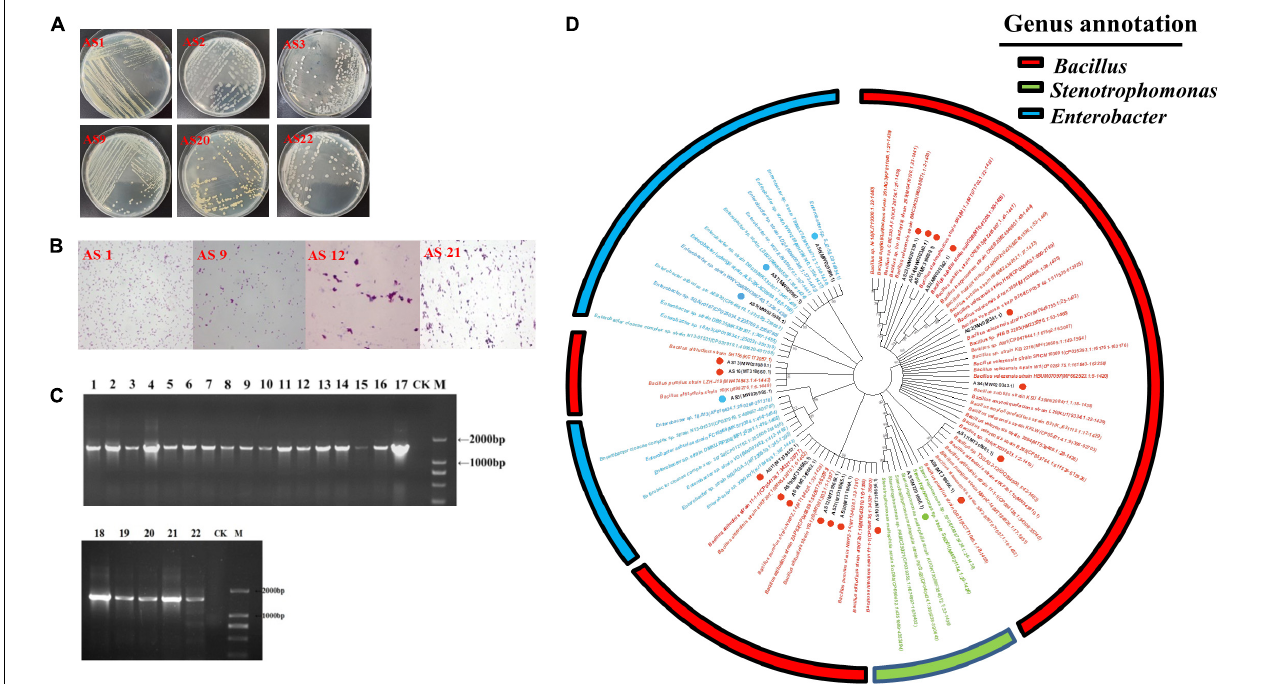
FIGURE 1 | Screening and identification of rhizosphere bacteria. (A) Representative colony morphology. After repeated isolation, monoclones were selected and cultured in LB liquid medium for 12–14 h at 37 ◦ C. The purified strain was streaked onto LB agar medium by the streak plate method, and the colony morphology was observed. (B) Gram staining. AS1 and AS9 represent gram-negative bacteria, and AS12 and AS21 represent gram-positive bacteria. (C) PCR results for 16S rRNA sequencing amplification of the 22 bacterial isolates. M: DL2000 DNA marker, CK: blank, the numbers 1–17 represent the bacterial isolates AS1, AS2, AS3, AS4, AS5, AS6, AS7, AS8, AS9, AS10, AS11, AS12, AS13, AS14, AS15, AS16, and AS17, and the numbers 18–22 represent the bacterial isolates AS18, AS19, AS20, AS21, and AS22, respectively. (D) Phylogenetic trees of the 22 bacterial isolates based on their 16S rRNA sequences.